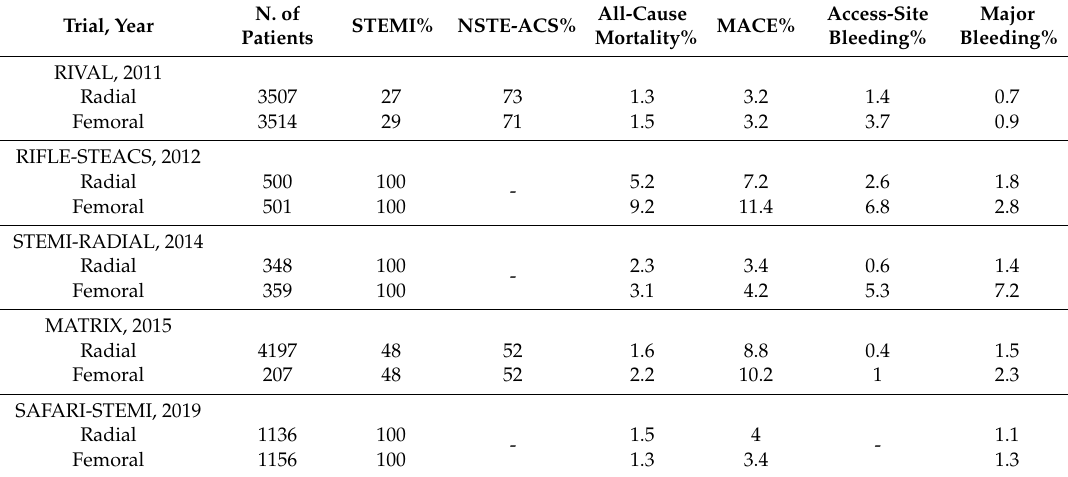
Access-Site Major All-Cause MACE% Bleeding% Bleeding% Mortality% 0.9